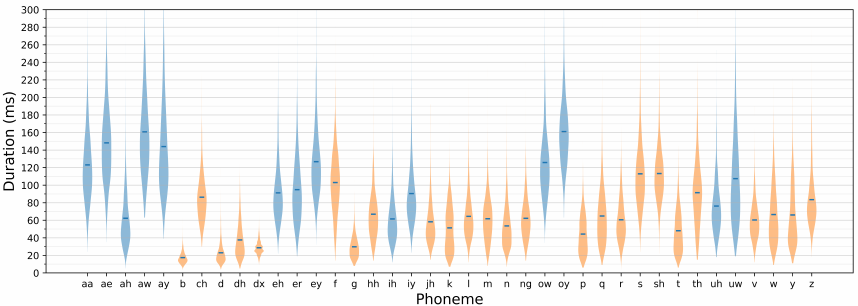
Figure 5. Violin plot showing duration of TIMIT core training set phonemes. Vowels are indicated in blue, while non-vowels in orange. Dark-blue ticks indicate mean phoneme durations.